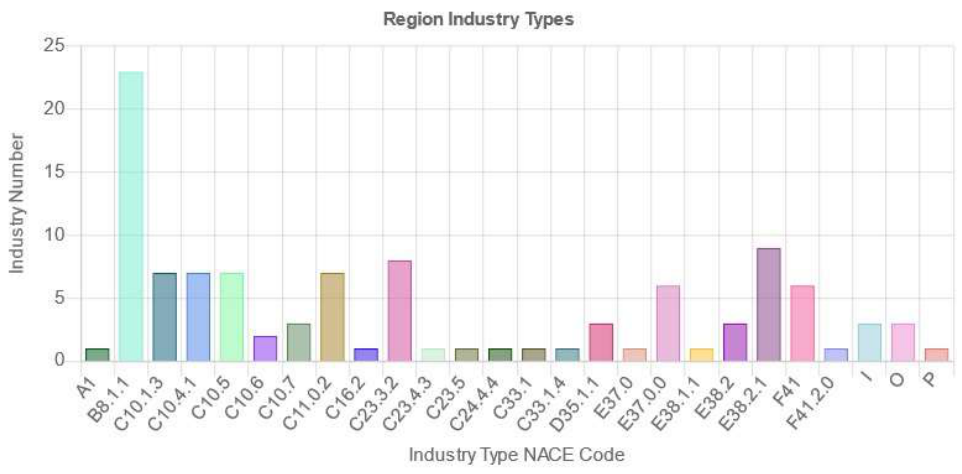
Figure 2. Industrial profile per type for the SWAN industrial ecosystem in